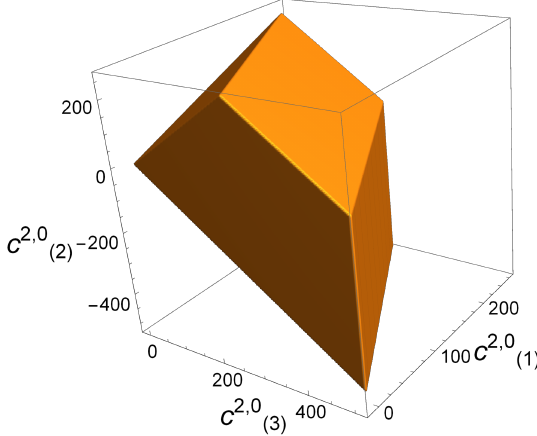
= 2 c 2 , 0 = 4 c 2 , 0 = 2 c 2 , 0 ) , i.e., the v 2 coefficients, , c 2 , 0 , c 2 , 0 1111 1122 1212 (1) (2) (3)